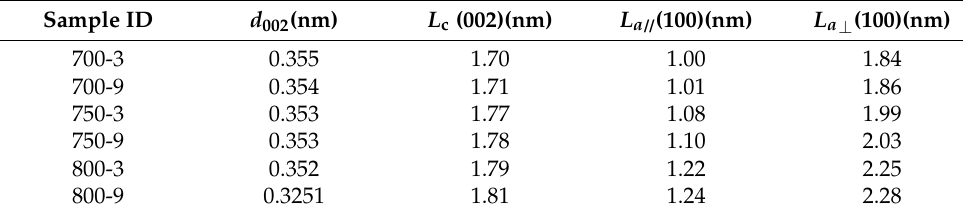
Table 3. The d 002 , L c and L a of the crystallite of the samples.